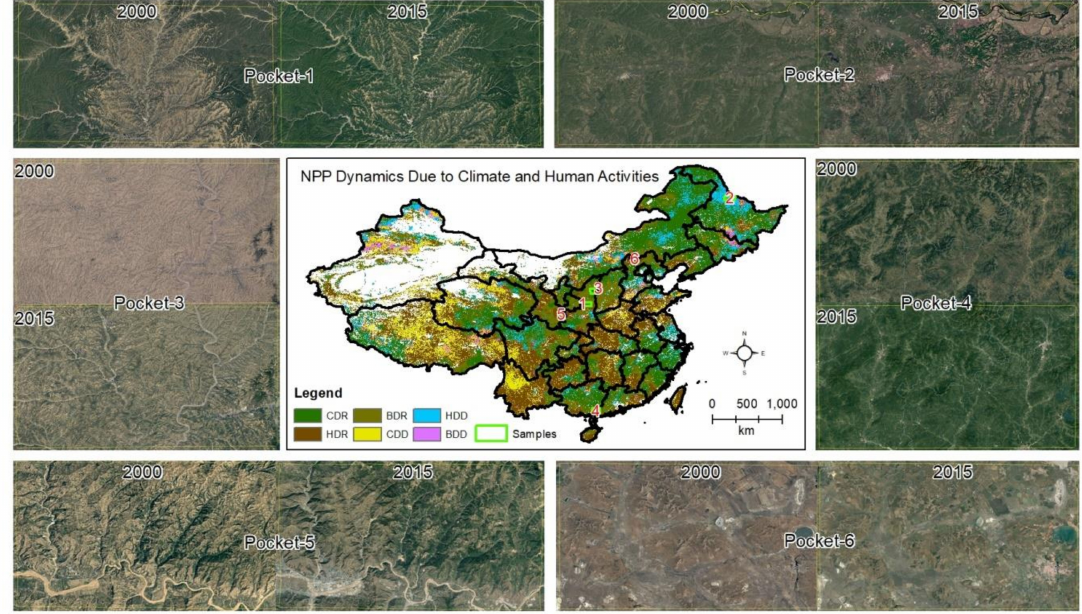
Figure 12. Vegetation changes during the restoration period in selected pockets, which verify the results illustrated in Figure